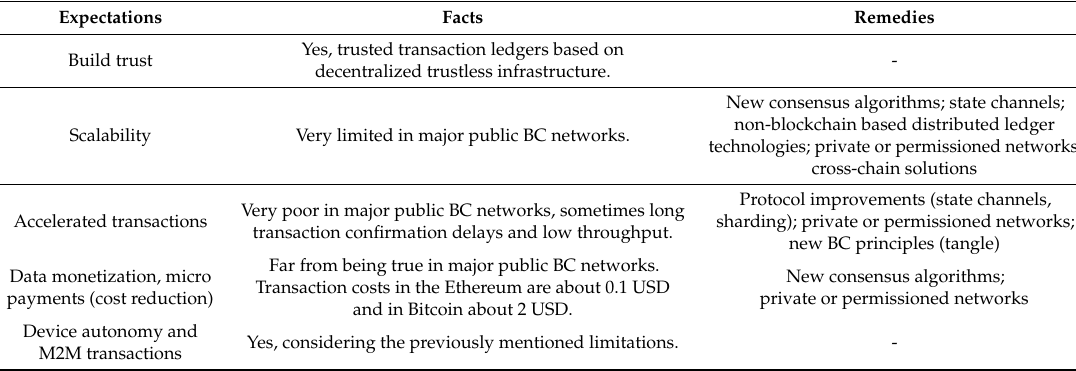
Table 1. Expectation put on blockchain technologies in the Internet of things